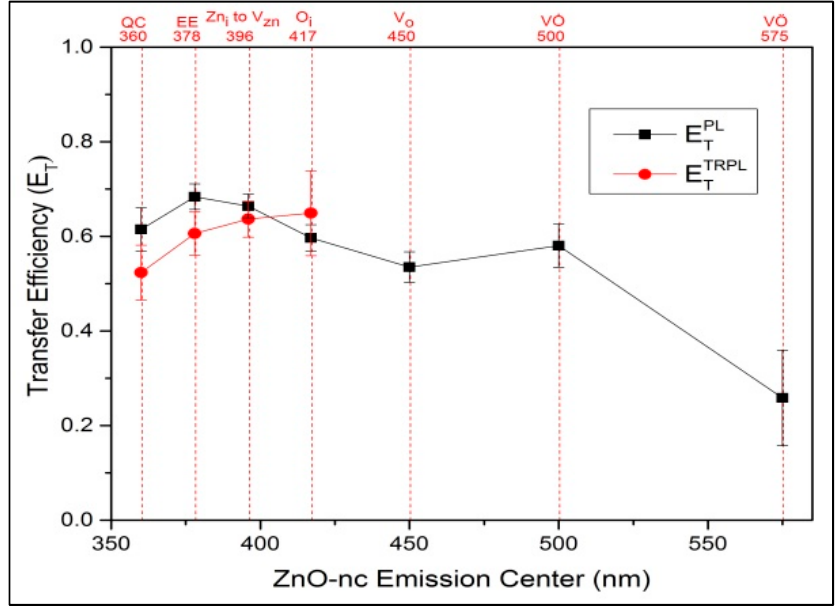
Figure 3. Transfer efficiency of ZnO nanocrystals emission centers due to the incorporation of the Eu 3+ ions, calculated from the time-resolved photoluminescence (TRPL) spectra and steady-state photoluminescence (PL) emission data, along with their respective error bars.